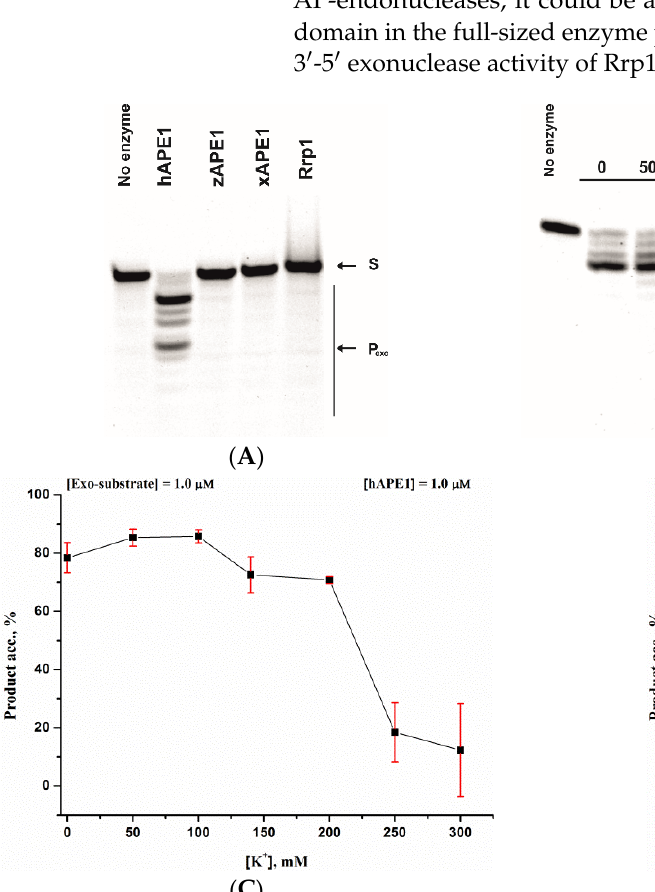
Figure 4. PAGE assays of the 3 ′ -5 ′ exonuclease activity of the APE1-like enzymes. A comparison of reactions of 3 ′ -5 ′ exonucleolytic degradation of recessed DNA in presence of 1 mM Mg 2+ and 50 mM K + ( A ). The impact of K + or Mg 2+ on the 3 ′ -5 ′ exonucleolytic DNA cleavage during the interaction with hAPE1 ( B ). Dependences of the cleavage efficacy of hAPE1 on K + ( C ) or Mg 2+ ( D ) concentration. Error was calculated by averaging each data point over at least three replicates.